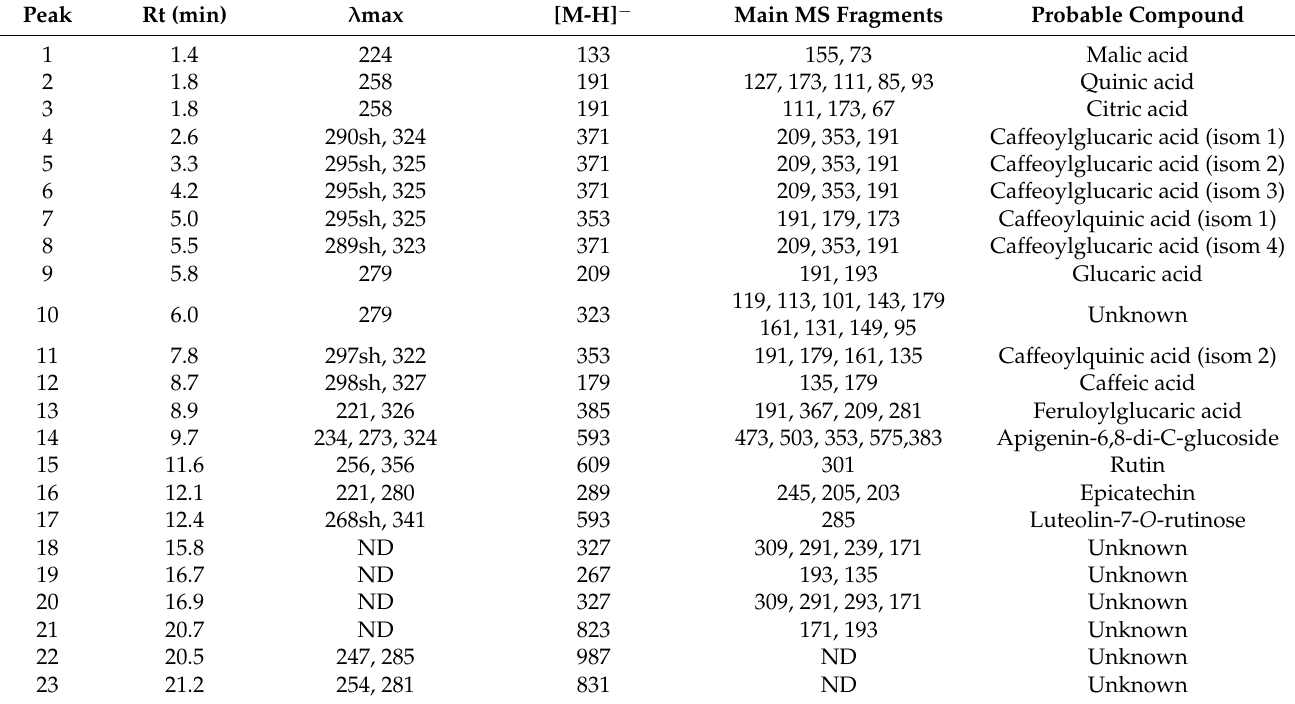
Table 4. Identification of UHPLC eluting fractions by UHPLC-DAD-MS n of Sulla carnosa hydro- methanolic